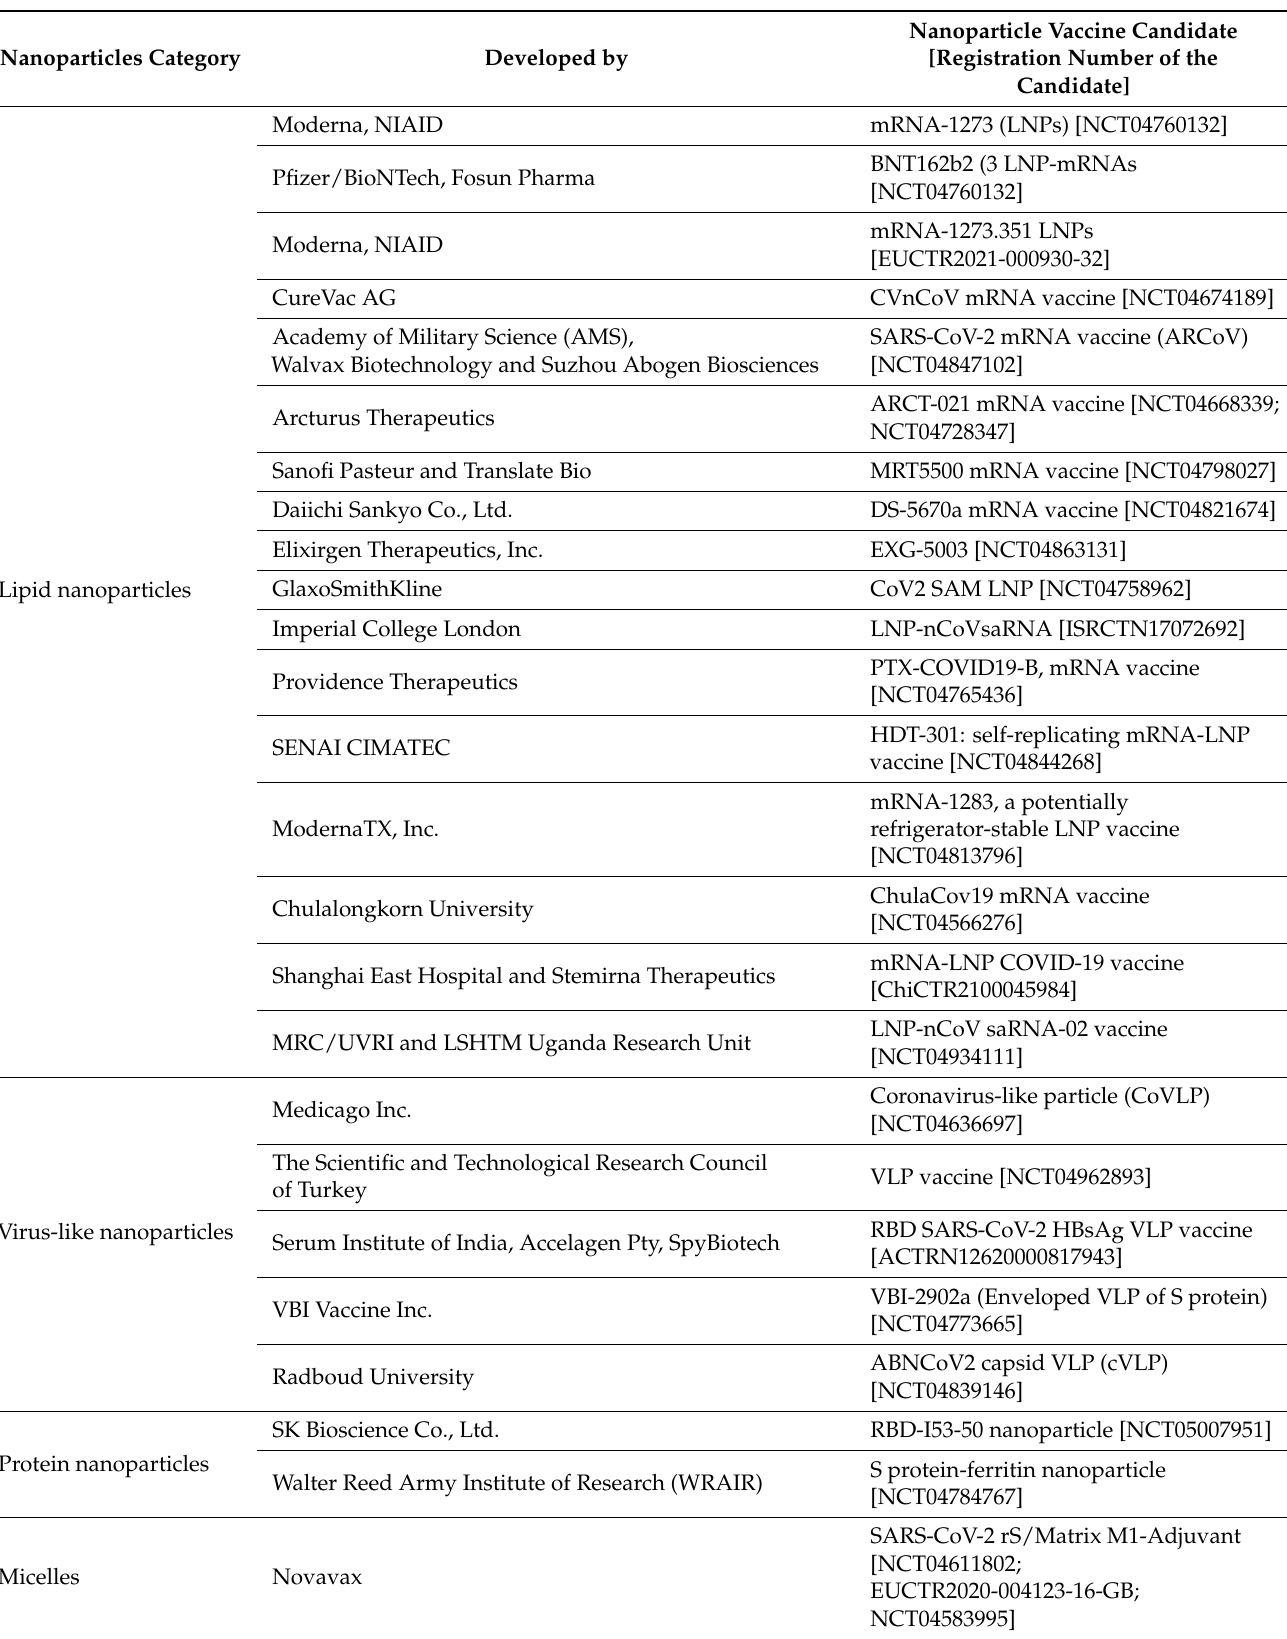
Table 2. Nanoparticle COVID-19 vaccine candidates in clinical